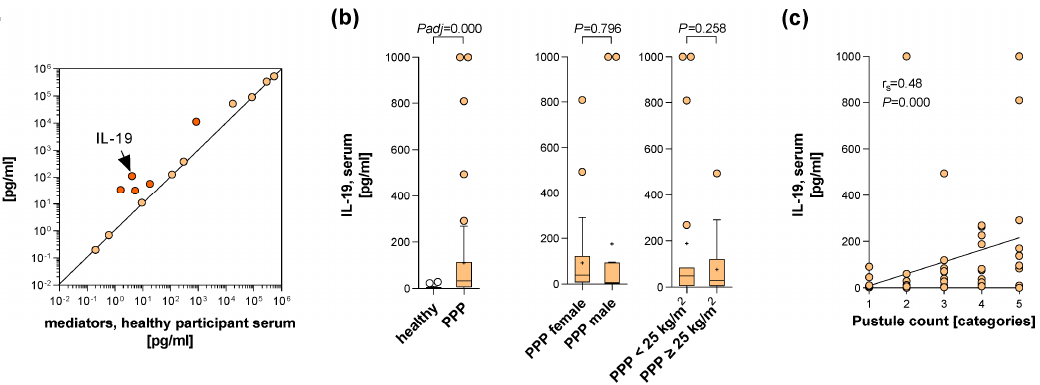
Figure 1. IL-19 serum levels are significantly upregulated in PPP patients. ( a – c ) Blood was collected from 68 PPP patients and 19 age- and sex-matched healthy control participants. Levels of 14 immune mediators were quantified in serum or plasma by ELISA (for the concrete number of samples analysed for each mediator, see Figure S1). ( a ) Mean levels of the 14 immune mediators quantified in serum or plasma from PPP patients and healthy participants were plotted against each other. ( b ) Serum IL-19 data from PPP patients and healthy participants are shown in Tukey-style box plots, with box centerline and "+" representing the median and mean, respectively. Differences between groups were analysed using the Mann-Whitney U-test ( p -value adjusted using the Bonferroni method for multiple testing (screening of 14 serum parameters) indicated) ( left ). Serum IL-19 data from the PPP patients were divided based on sex ( middle ; 47 females, 13 males) and body mass index (BMI) ( right ; 20 normal-weight patients with BMI < 25 kg/m 2 , 40 pre-obese or obese patients with BMI ≥ 25 kg/m 2 ) of patients. Data are shown in Tukey-style box plots. Differences between groups were analysed using Mann-Whitney U-test ( p -values indicated). ( c ) Serum IL-19 data from 60 PPP patients were plotted against the pustule count category (pustule count on the most affected location categorised into the levels 1 to 5 corresponding to 0, 1–10, 11–25, 25–60, and > 60 pustules) of these patients and correlation between both parameters was tested by Spearman’s correlation test (correlation coefficients r s and p -value